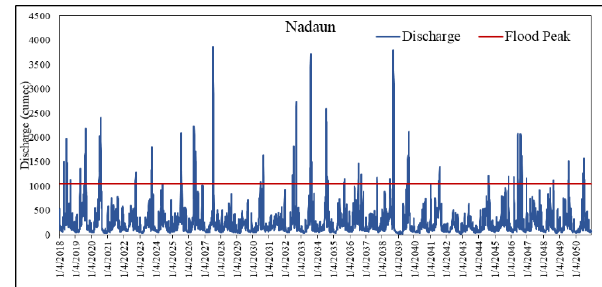
Figure 23 Simulated discharge at Nadaun outlet for near future period